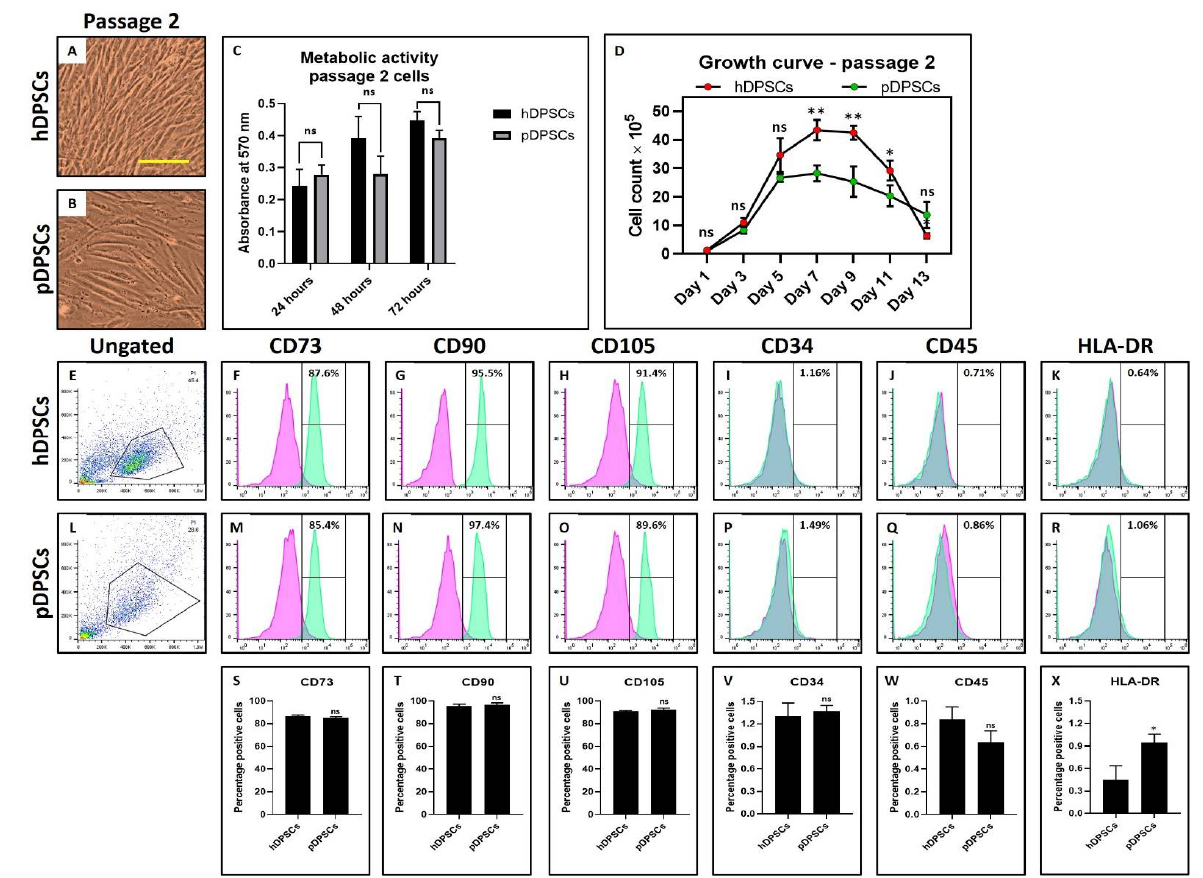
Figure 1. Assessment of morphology, metabolic activity, growth and MSC markers in DPSCs from healthy and periodontitis-affected teeth at Passage 2. ( A , B ) photomicrograph showing the morphology of hDPSCs and pDPSCs at Passage 2. Scale bar = 100 µm. ( C ) comparative analysis of the metabolic activity in hDPSCs and pDPSCs at 24, 48 and 72 h. ( D ) comparative analysis of cellular growth in hDPSCs and pDPSCs. ( E – X ) comparative analysis of MSC-specific cell surface maker analysis for CD73, CD90, CD105, CD34, CD45 and HLA-DR in hDPSCs and pDPSCs. Experiments were repeated in triplicates for n = 3. ns not significant, * p < 0.05 and ** p < 0.01. hDPSCs: dental pulp stem cells from healthy teeth and pDPSCs: dental pulp stem cells from periodontitis-affected teeth.